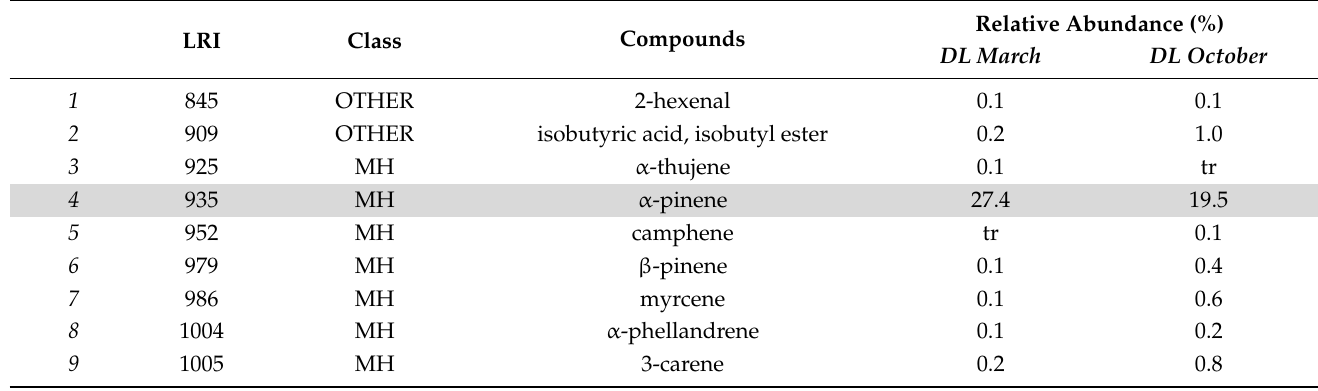
Table 2. GC-MS profiles of the essential oils obtained from the dried leaves ( DL ) of Myrtus communis subsp. communis collected in March and October